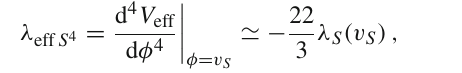
Fig. 1 RG flow of scalar coupling constants from the Planck scale to the electroweak scale with the boundary condition (3) and the bench- mark value